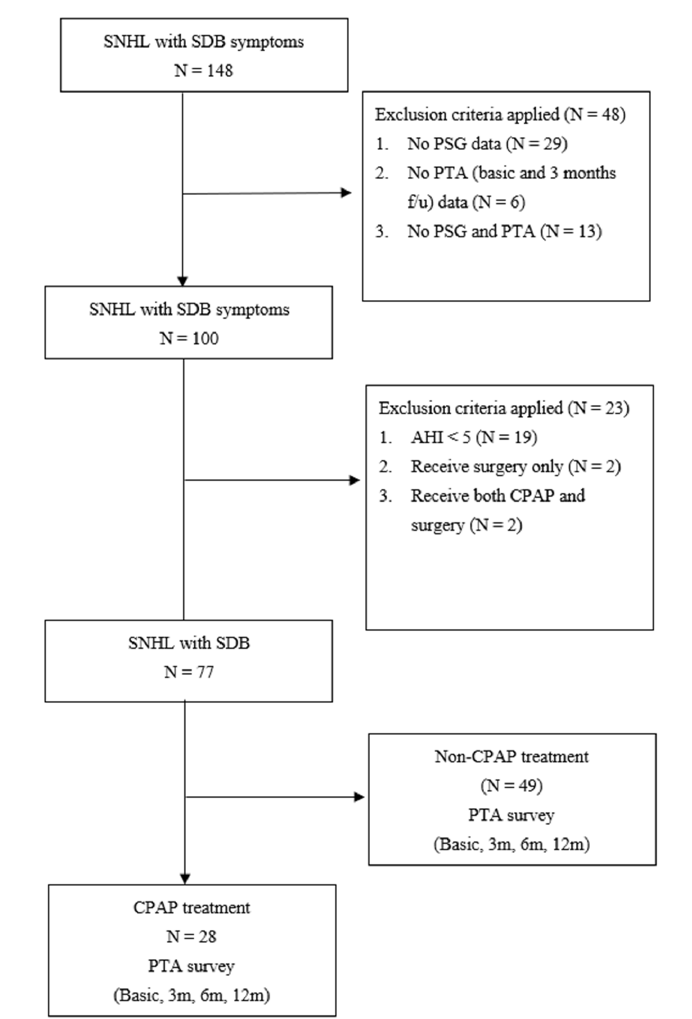
Figure 1. Flow chart showing recruitment methodology. Hearing thresholds were measured by pure-tone audiometry (PTA) at baseline (BL), three (3 m), six (6 m), and 12 months (12 m) in the 77 patients. Abbreviations : SNHL, sensorineural hearing loss; SDB, sleep-disordered breathing; PSG, sleep polysomnography study; CPAP continuous positive airway pressure therapy group.